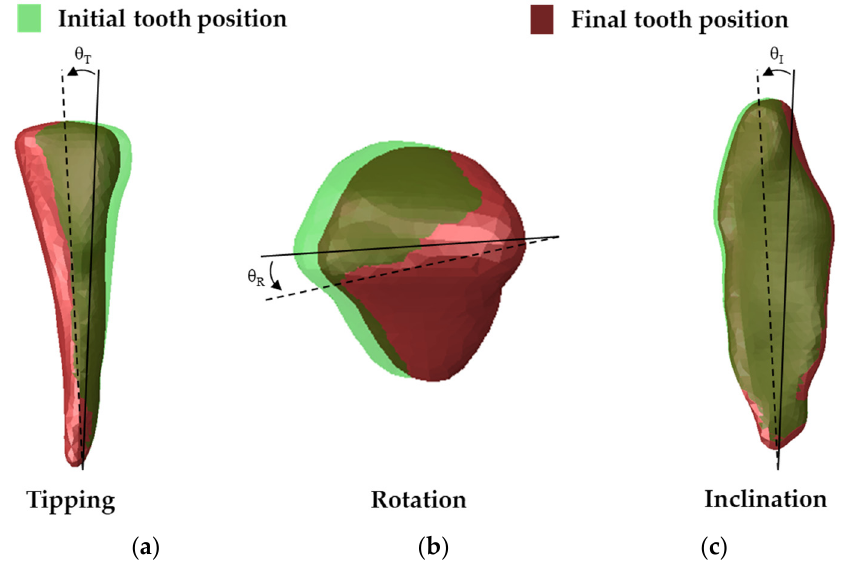
Figure 4. Tooth movements before and after loading conditions. ( a ) tipping; ( b ) axial rotation; ( c ) buccolingual inclination. Table 2. Tooth movements measured for 0.5-mm-thick aligner models.